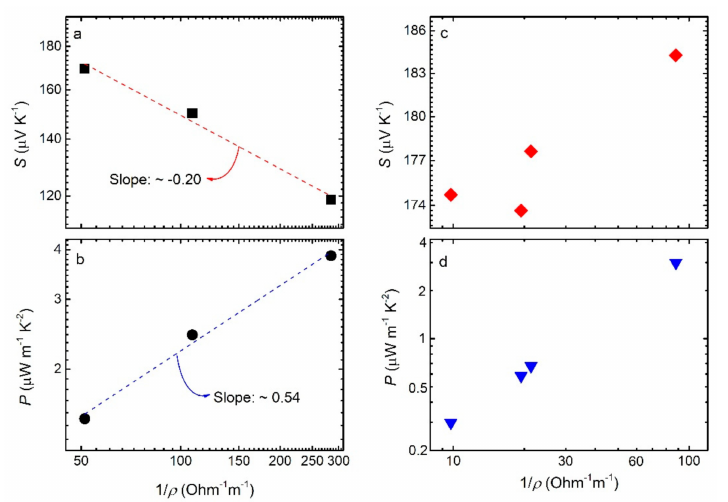
(cid:16) (cid:17) m BST = 80 and m ABS 20